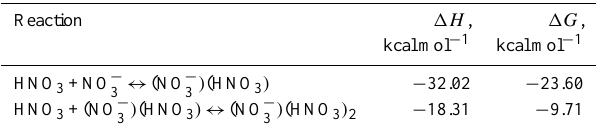
Table 1. Thermochemical parameters (at the PW91/6-311++G(3df, 3pd) level) for the clustering of nitrate ions with nitric acid. All val- ues correspond to 298K and 1atm reference pressure for all species.